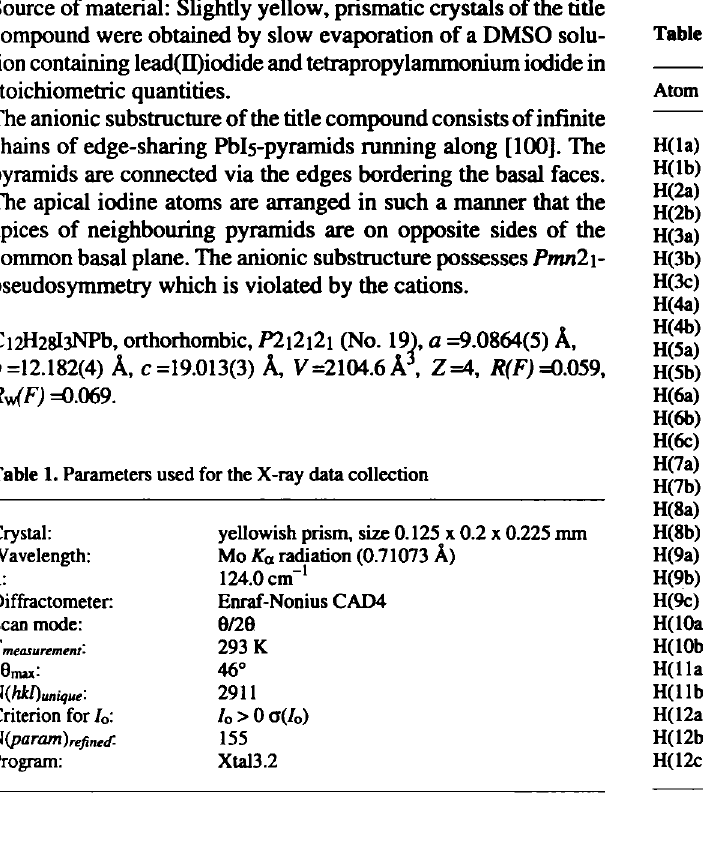
Table 2. Final atomic coordinates and displacement parameters (in Â 2